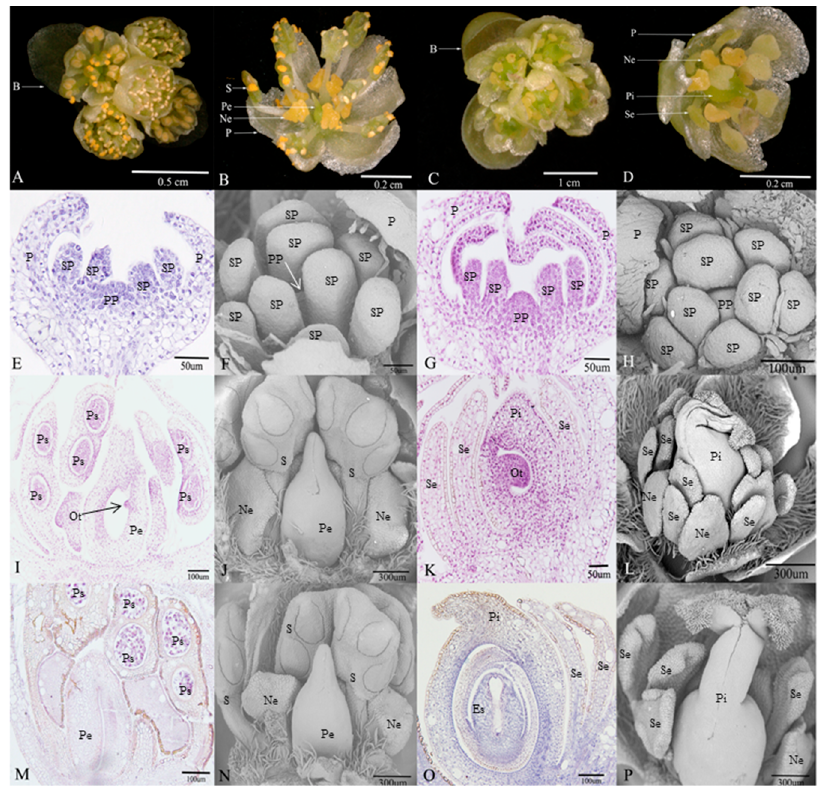
Figure 1. Morphological comparison of flower structure between male and female, and the Figure1. Morphologicalcomparisonofflowerstructurebetweenmaleandfemale, andthemicroscopical microscopical features of degenerative organs in male and female flowers during the three features of degenerative organs in male and female flowers during the three developmental stages developmental stages in Litsea cubeba . ( A – B ) Umbel inflorescences and floral organ structures in male in Litsea cubeba . ( A , B ) Umbel inflorescences and floral organ structures in male flower; ( C , D ) umbel flower; ( C – D ) umbel inflorescences and floral organ structures in female flower; ( E – F ) stamen inflorescences and floral organ structures in female flower; ( E , F ) stamen primordium and pistil primordium and pistil primordium occur in male flower; ( I – J ) the early stage of pistillode and primordium occur in male flower; ( I , J ) the early stage of pistillode and stamen pollen sac formation stamen pollen sac formation in male flower; ( M – N ) pollen maturity stage, morphological structure of in male flower; ( M , N ) pollen maturity stage, morphological structure of pistillode in male flower; pistillode in male flower; ( G – H ) stamen primordium and pistil primordium occur in female flower; ( G , H ) stamen primordium and pistil primordium occur in female flower; ( K , L ) the early stage of ( K – L ) the early stage of staminodes and embryo sac formation in female flower; ( O – P ) embryo sac staminodes and embryo sac formation in female flower; ( O,P ) embryo sac mature stage, morphological mature stage, morphological structure of staminode in female flower. (B: bracts; S: stamens; Pe: structure of staminode in female flower. (B: bracts; S: stamens; Pe: pistillode; Ne: nectaries; P: perianth; pistillode; Ne: nectaries; P: perianth; Se: staminode; Pi: pistil; SP: stamen primordium; PP: pistil Se: staminode; Pi: pistil; SP: stamen primordium; PP: pistil primordium; Ps: pollen sac; Es: embryo sac; primordium; Ps: pollen sac; Es: embryo sac; Ot: ovule tissue). Ot: ovule